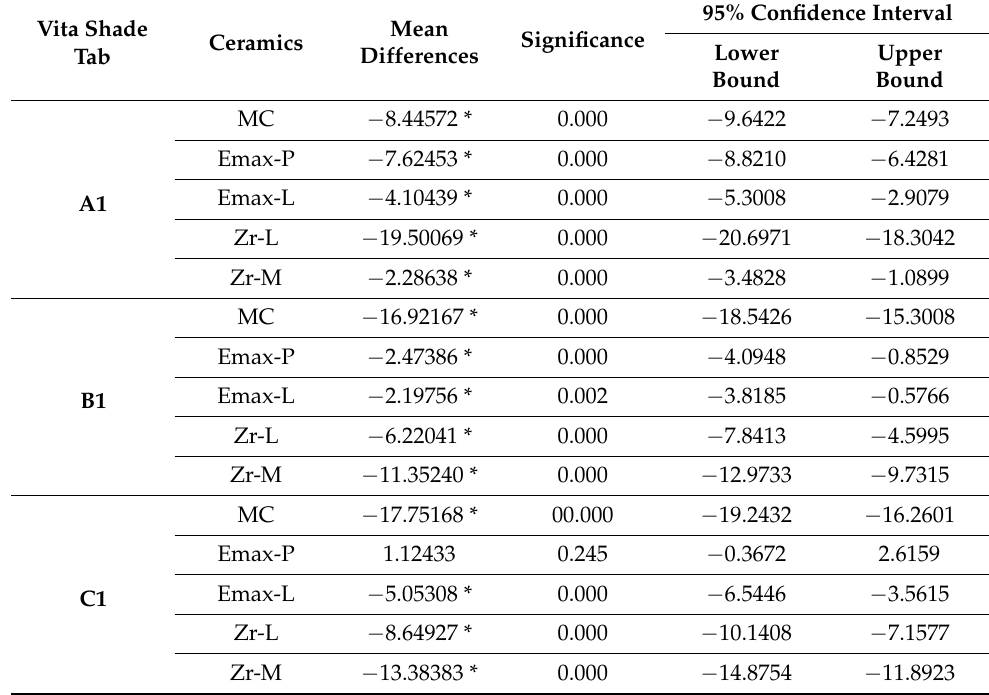
Table 5. Mean differences and multiple comparisons of the delta E ( ∆ E) values with the ∆ E of vita shade guide